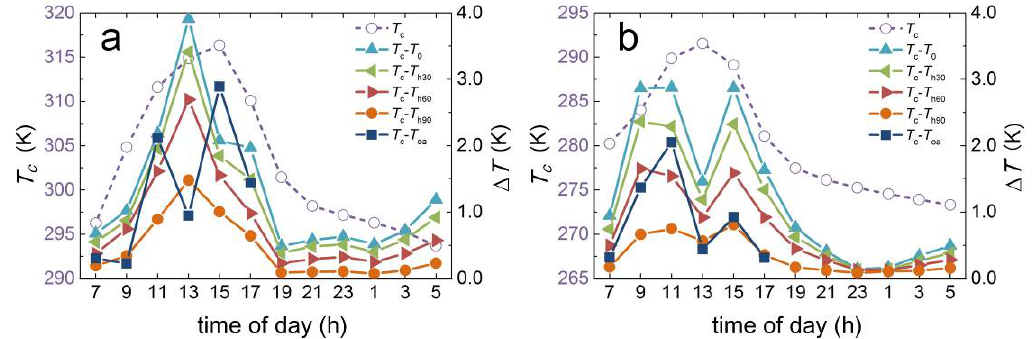
Fig.5 Comparison of T H ( Ω ) and T c . And, (a) and (b) indicate summer and winter, respectively. T c is complete surface temperature, T hx is integral temperature of the azimuth angle is from 0 to 360° and the zenith angle is from 0 to x, T oa is integral temperature of optimal view area. The vertical axis on the left and right shows the temperature value of T c and the absolute difference between T hx , T oa and T c , respectivel.